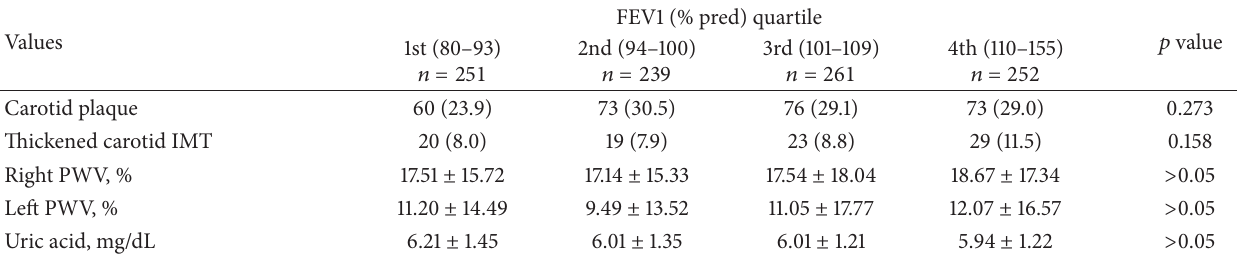
Table 3: Percentage of carotid plaque, thickened IMT, value of PWV (%), and uric acid by FEV1 (% pred) quartiles.